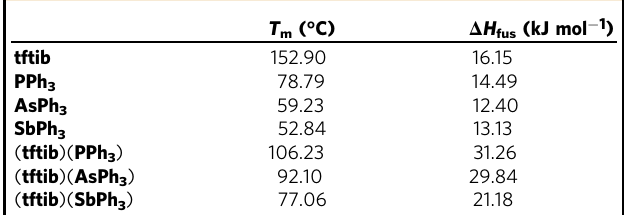
Table 3 Melting points ( T m ) and the enthalpies of fusion ( Δ H fus ) for cocrystal components tftib, PPh 3 , AsPh 3 and SbPh 3 , and the cocrystals (tftib)(PPh 3 ), (tftib)(AsPh 3 ), and